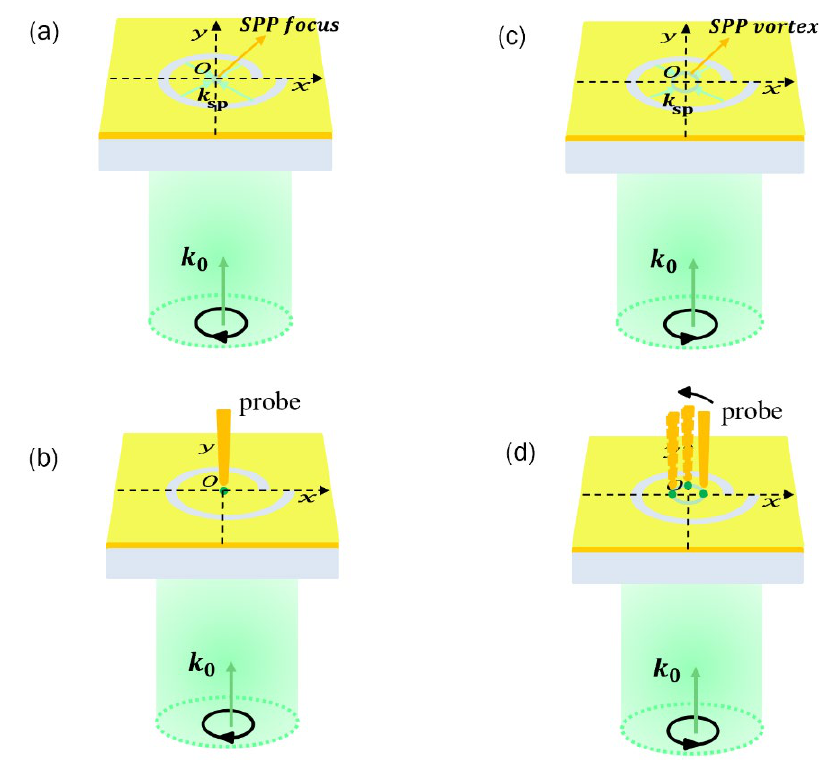
Figure 2. Formation of the ( a ) SPP focus and ( c ) SPP vortex when the incident light is LCP and RCP, respectively. Formation of the enhanced electric field ( b ) when the probe is above the SPP focus and ( d ) at different positions when the probe is located at different positions above the SPP vortex.